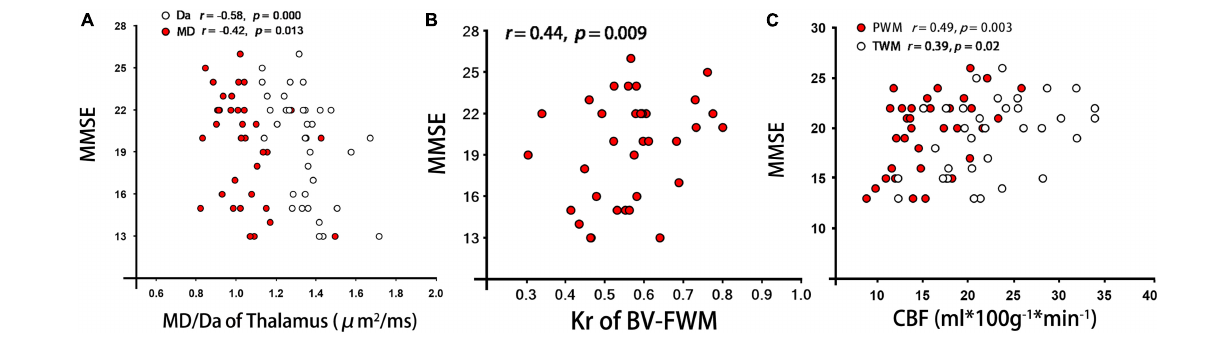
FIGURE 3 | Correlations analyses between each DKI/ASL derived parameter and MMSE scores from patients with BD. (A–C) represent the correlation of MMSE with MD/Da of Thalamus, Kr of BV-FWM, and CBF of PWM/TWM, respectively. Note: PWM/TWM, parietal/temporal white matter; MMSE, Mini-Mental State Examination.